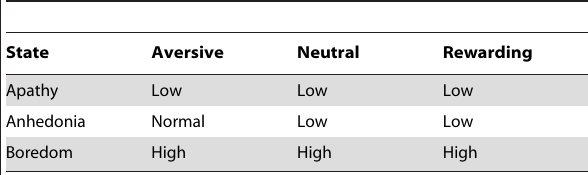
Table 1. Interest in different types of stimuli depending on psychological